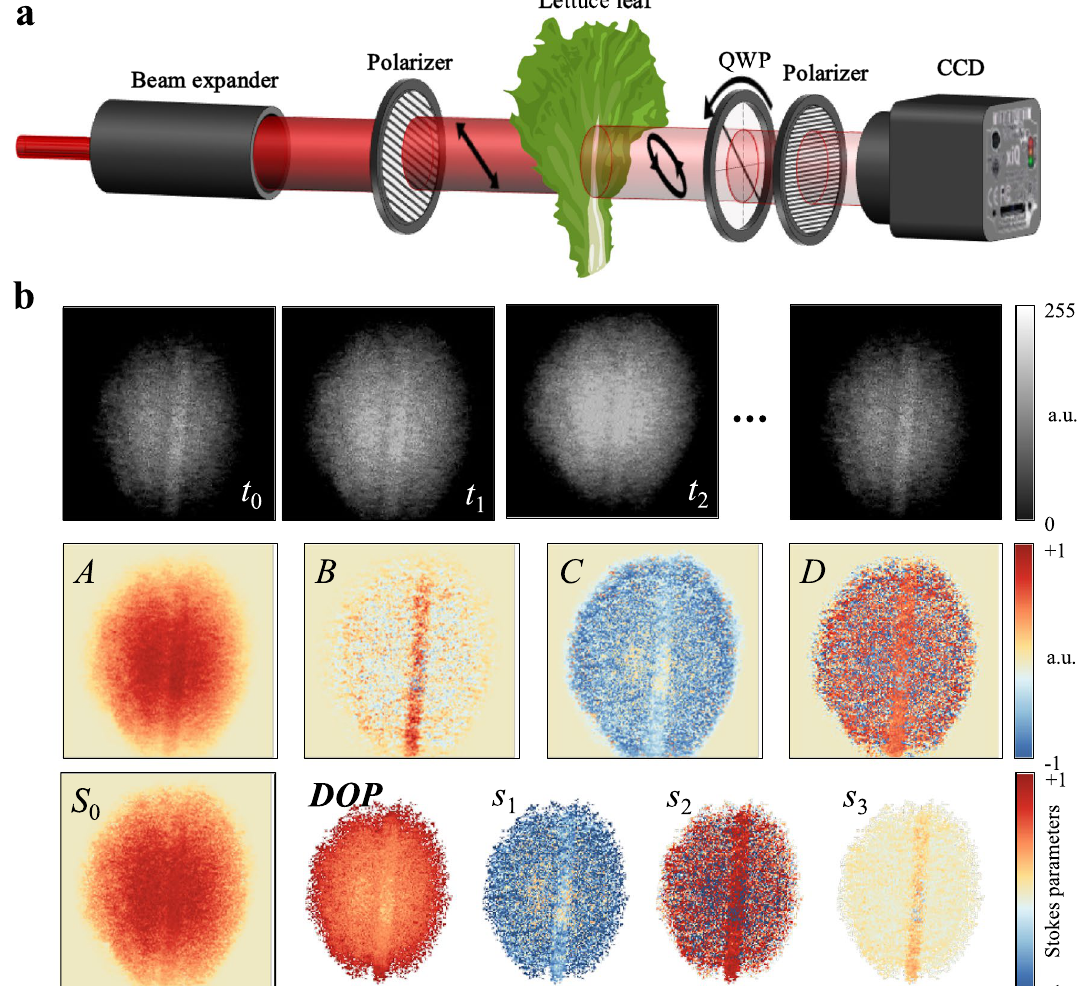
Figure 1. ( a ) Plant monitoring system using Stokes polarimetry. ( b ) Examples of processes to obtain the Stokes image. Each row corresponds to intensity, Fourier coefficients, and Stokes images in order of the first row to the third